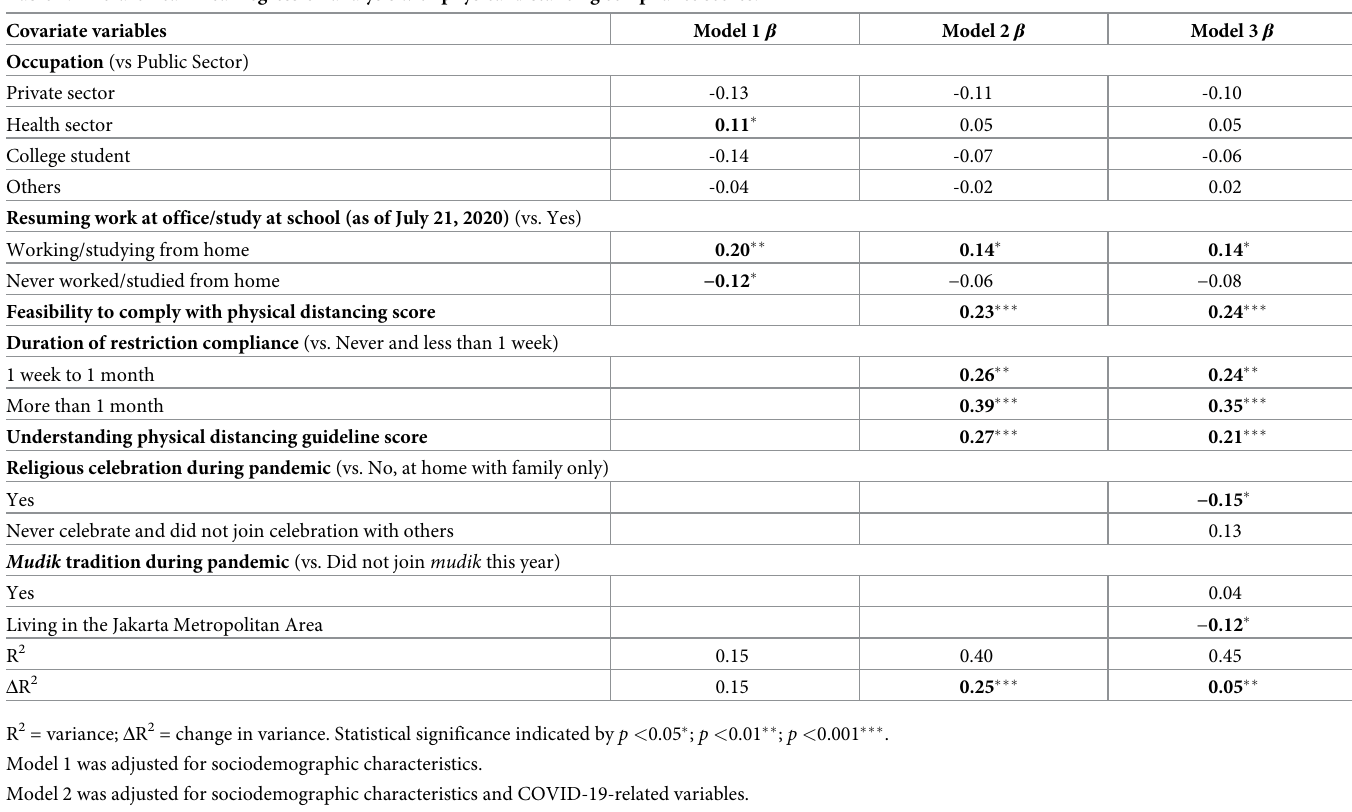
Table 2. Hierarchical linear regression analysis with physical distancing compliance